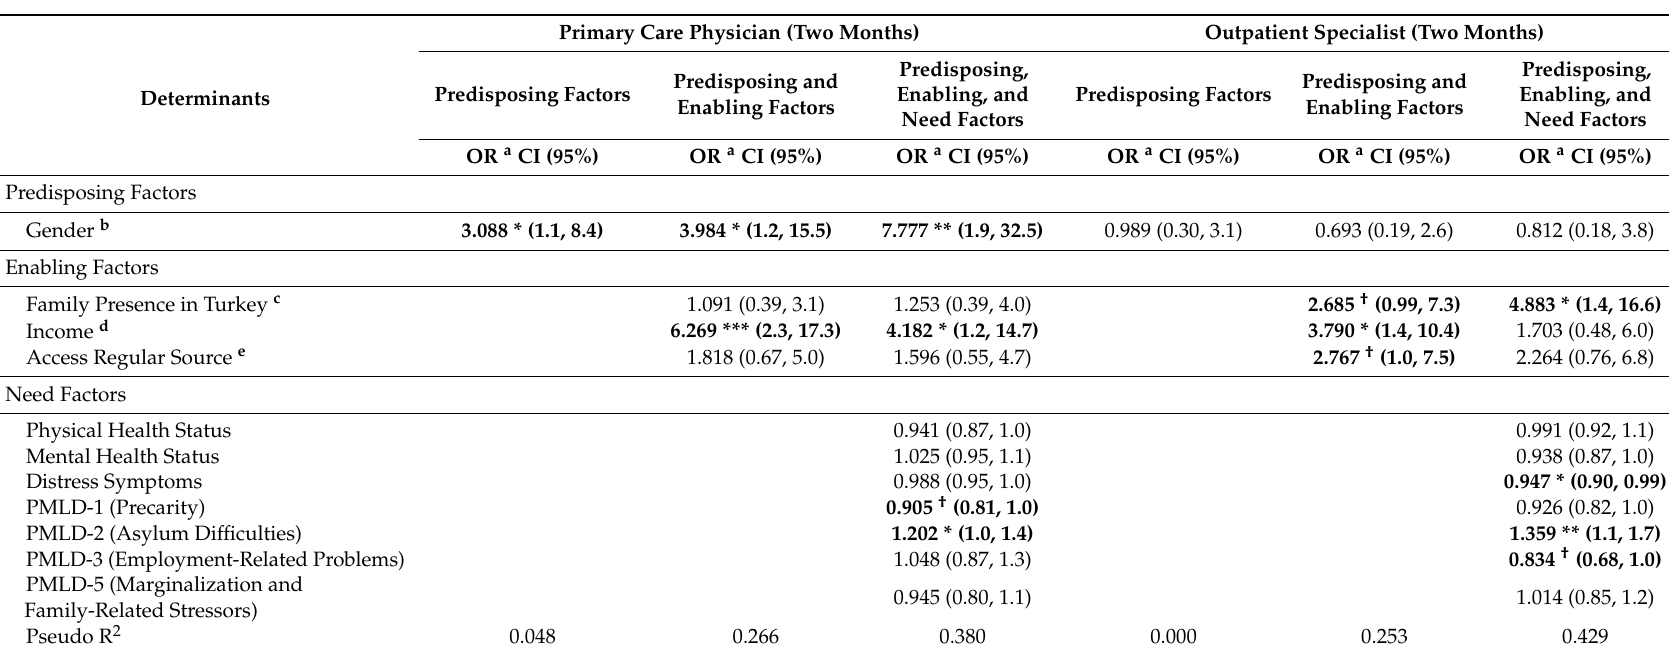
Table 2. Logistic regression analysis showing associations between selected determinants and utilization of general practitioner and outpatient specialist services. Determinants